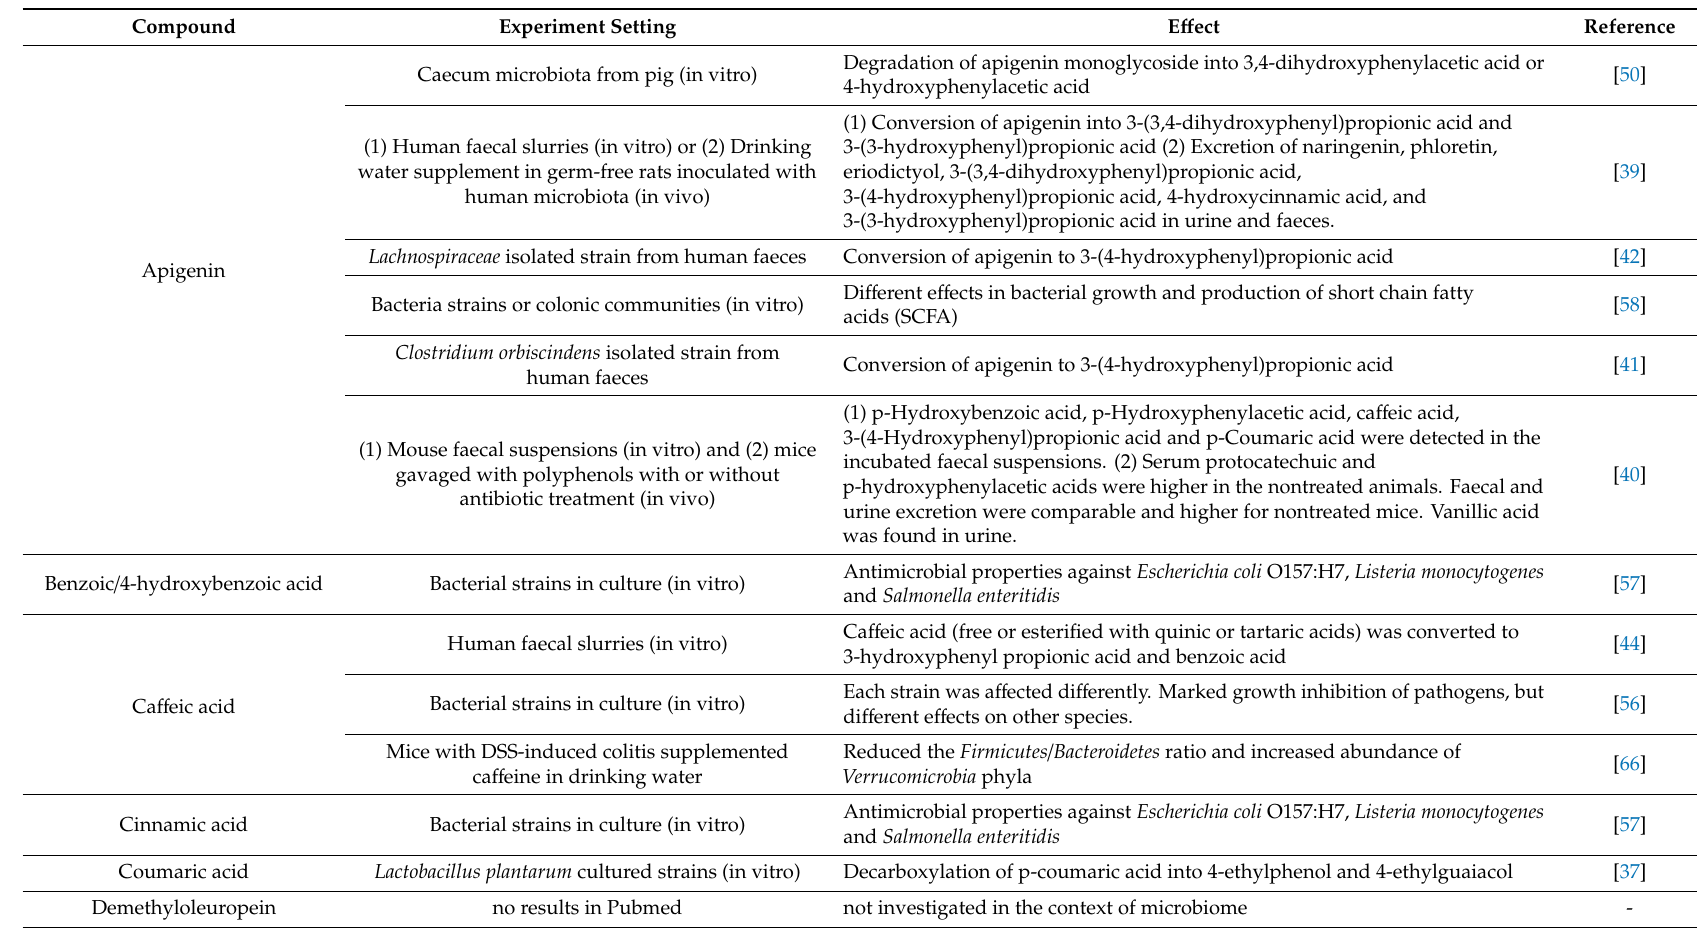
Table 1. Studies which analyzed the e ff ects of singleolive oil phenolic-compounds (OOPC) on gut microbiota and